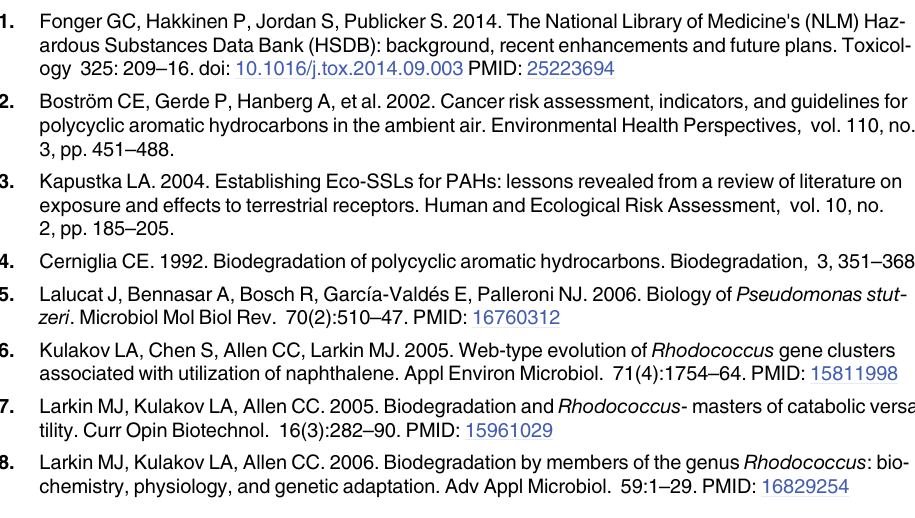
S2 Table. Gene abundances of predominant COG classes found in the genomes of selected rhodococcus species relative to strain M213 using the IMG and NCBI annotations. Strain M213 contained high number of COGs for biodegradative enzymes such as dioxygenases and cytochrome